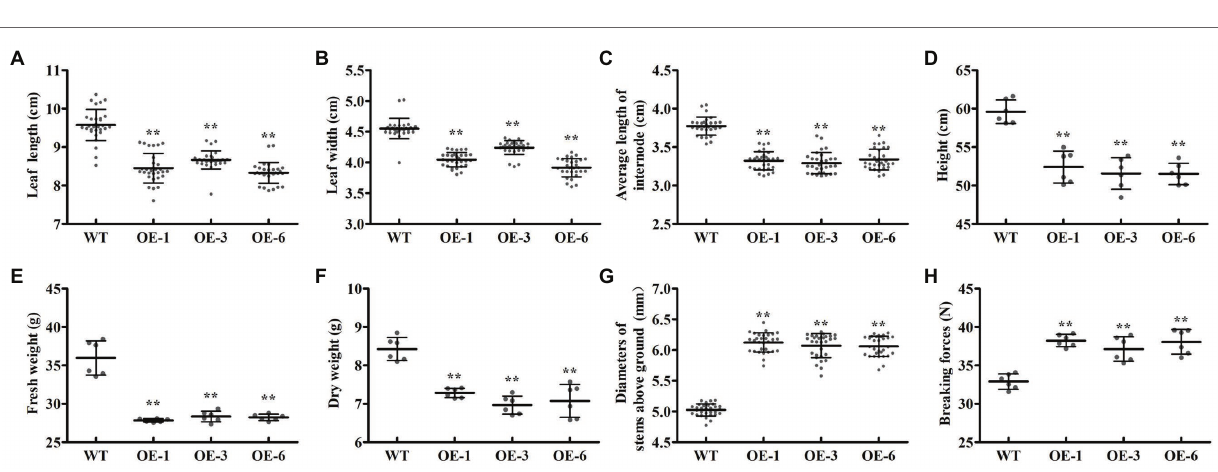
FIGURE 4 | Effect of PtrGATA12 overexpression on growth-related traits in P. trichocarpa . (A–H) Represent the leaf lengths, leaf widths, average lengths, plant heights, fresh weights, dry weights internode base diameters, and breaking forces of 90 days old WT and PtrGATA12 transgenic lines (OE-1, OE-3, and OE-6), respectively. Each error bar represents the SD of three biological replicates. Asterisks indicate levels of significance (Dunnett’s test; **, p <